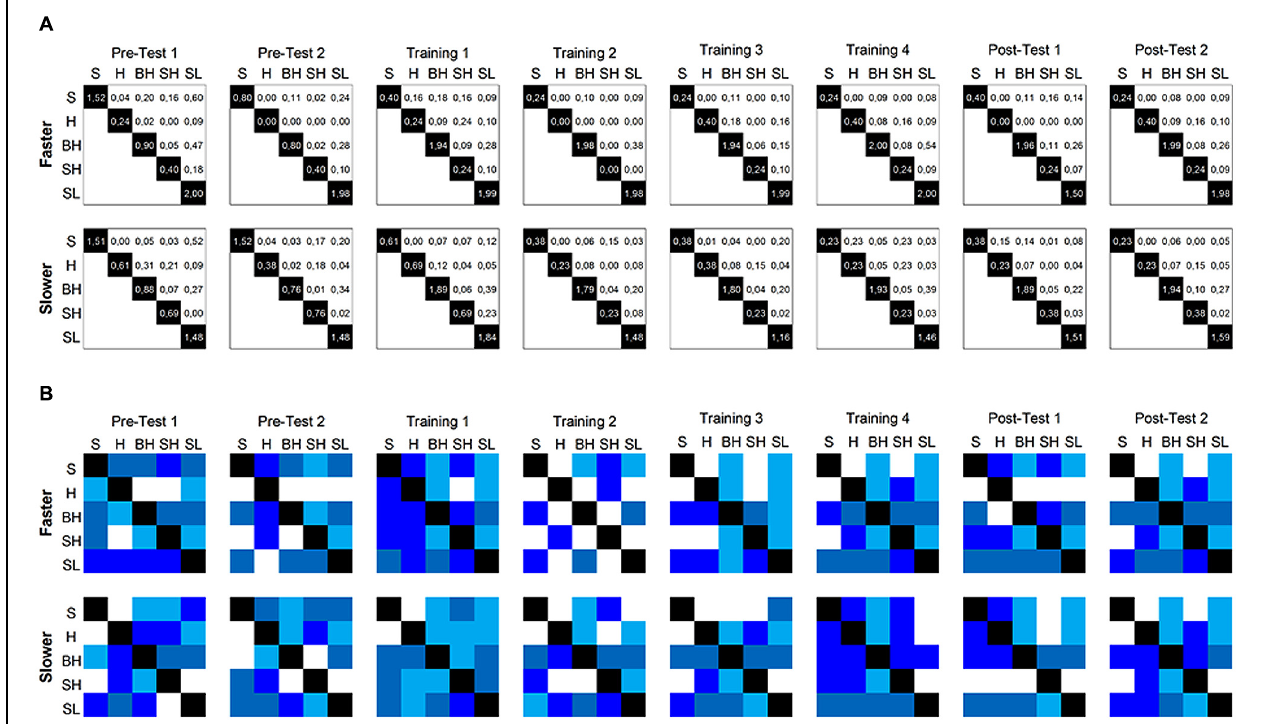
FIGURE 7 | Average mutual information (A) and degree of order (B) obtained for each trial-type pair, separated by segment and condition [the diagonal in (A) shows H of each trial type]. The shading represents a quartile of degree of order (white: lowest level; blue: highest level). S, small-wins pair; H, heavy-wins pair; BH, big/heavy-wins pair; SH, small/heavy-wins pair; SL, small/light-wins